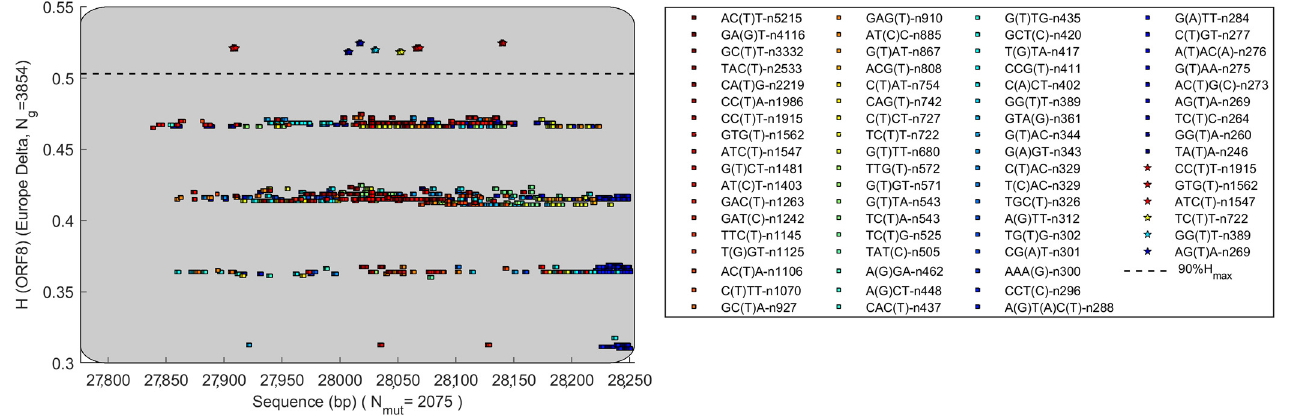
Figure 5. The ORF8 gene of Delta variant has mutated with different HGS. The dataset contains 3854 genomes with geolocation of Europe.